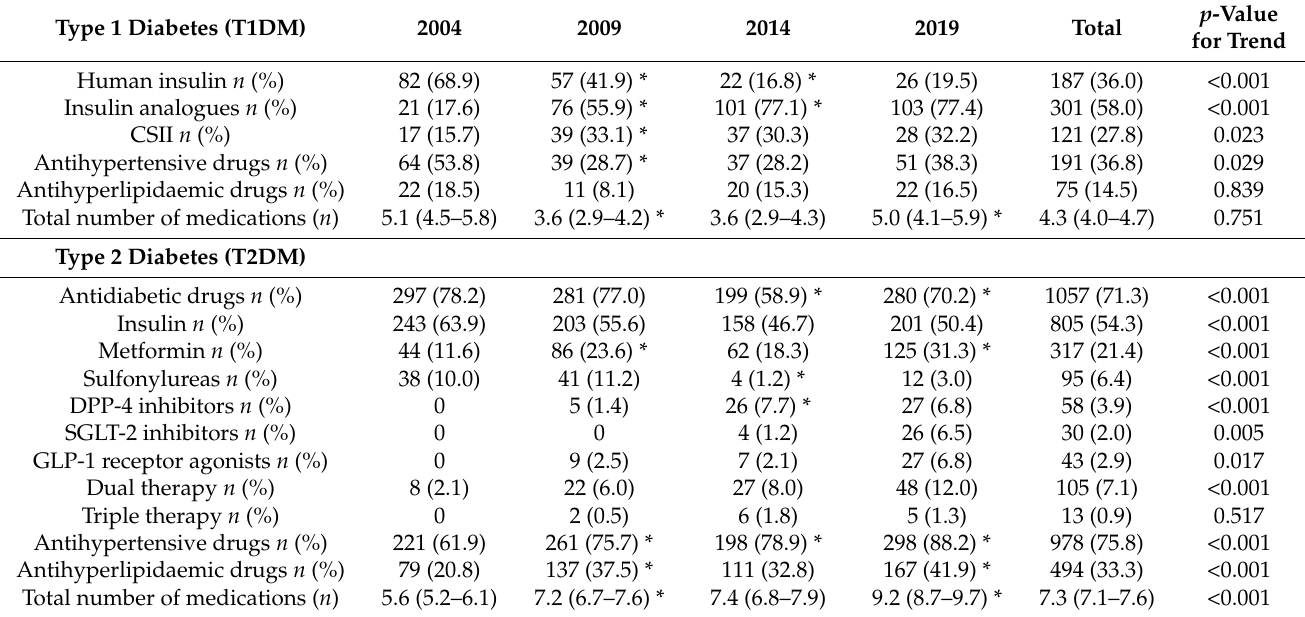
Table 6. Drug therapy of patients in tertiary care